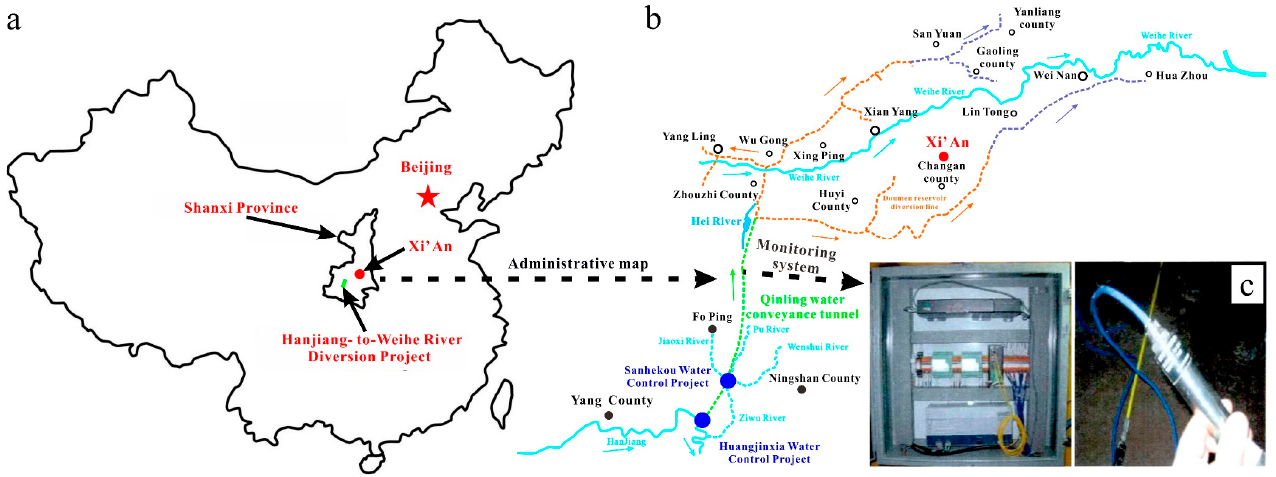
Figure 1. ( a , b ) Geographical location/layout map of the Hanjiang-to-Weihe River diversion project [42] , ( c ) Microseismic monitoring system of the Engineering Seismology